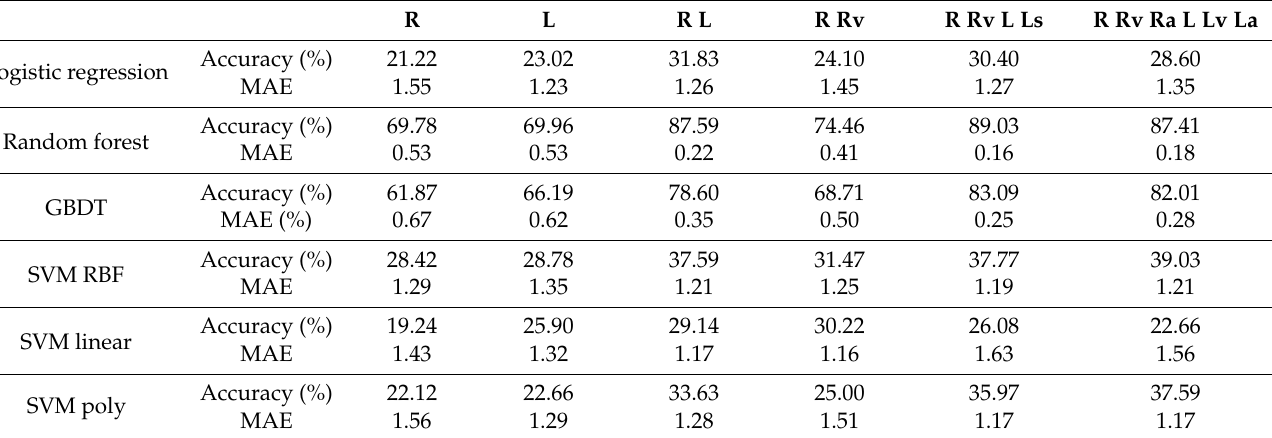
Table 3. Performance of the statistical data for hip joint angle, angular velocity and angular accelera- tion in different models.